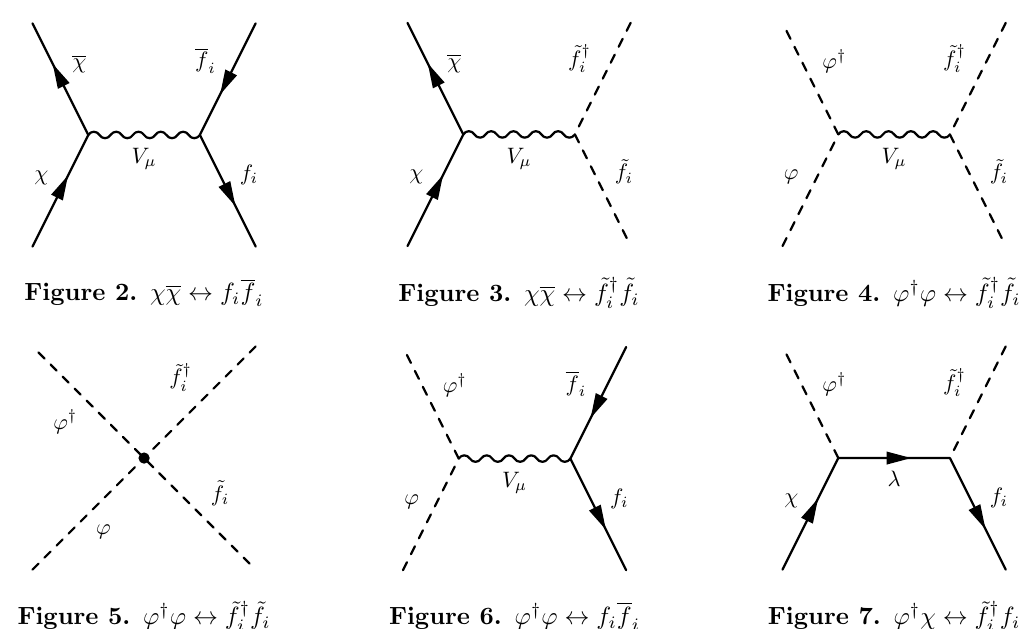
y ’ $ f i f i Figure 7. ’ y (cid:31) $